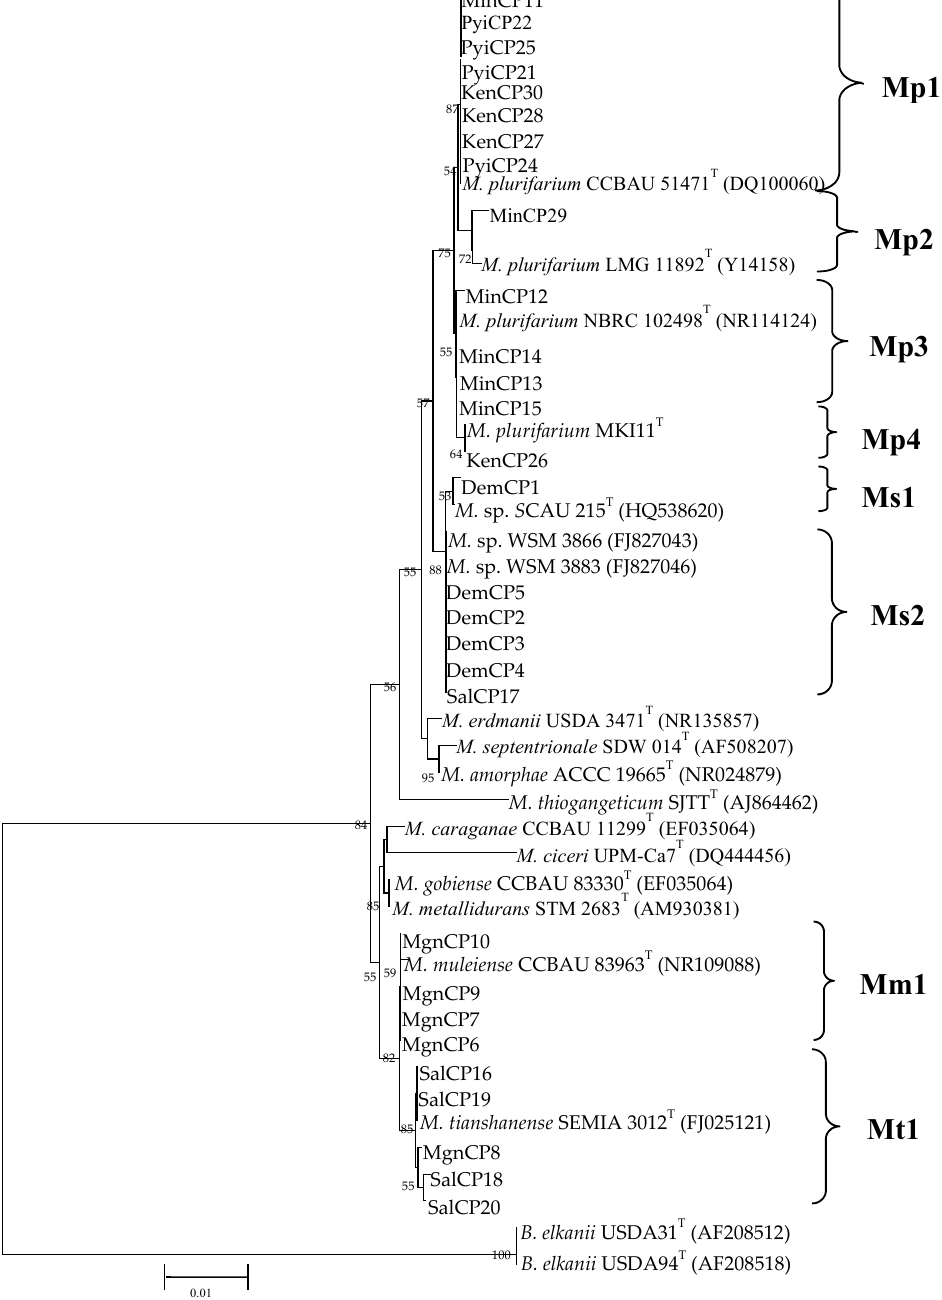
Figure 2. Position of the 30 strains in the phylogenetic tree based on the 16S rRNA sequences of related Mesorhizobium strains (in italics) retrieved from GenBank. The tree was constructed by the neighbor-joining method with the Kimura 2-parameter (K2P) distance correlation model and 1,000 bootstrap replications. Bootstrap values above 50% are indicated at the nodes. Bar, 0.02 K nuc in nucleotide sequences. Accession numbers of the reference strains, including all type strains of Mesorhizobium , are shown in parentheses. M: Mesorhizobium and B: Bradyrhizobium . The clustering of isolates and their distribution throughout the total studied area is noted into the tree: Mp1 = Mesorhizobium plurifarium cluster 1; Mp2 = Mesorhizobium plurifarium cluster 2; Mp3 = Mesorhizobium plurifarium cluster 3; Mp4 = Mesorhizobium plurifarium cluster 4; Ms1 = Mesorhizobium sp.cluster 1; Ms2 = Mesorhizobium sp.cluster 2; Mm1 = Mesorhizobium muleiense cluster 1; Mt1 = Mesorhizobium tianshanense cluster 1.